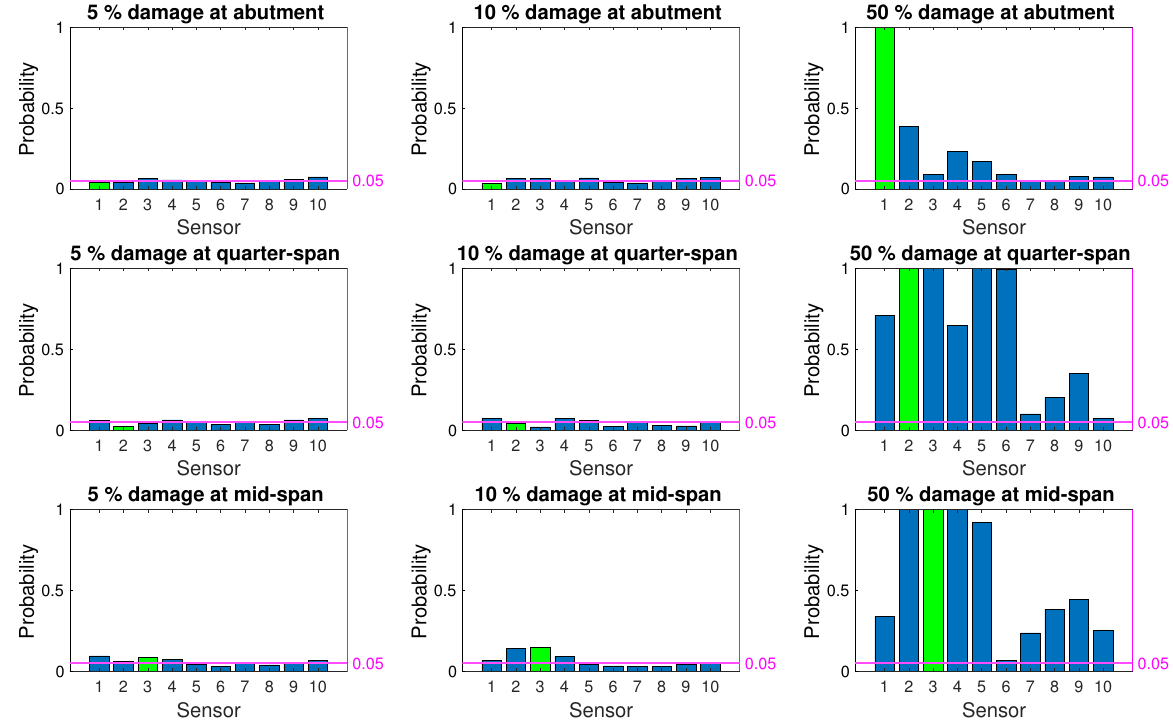
Figure 8. Probability of damage detection using modal curvature damage indicator for 5%